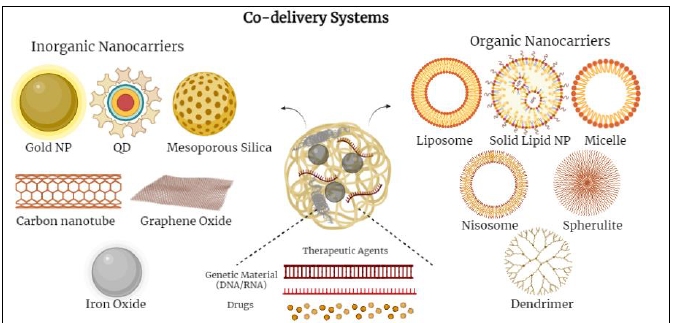
Figure 1. Schematic diagram demonstrating various co-delivery systems and the different inorganic- and organic-based nanocarriers. and organic-based